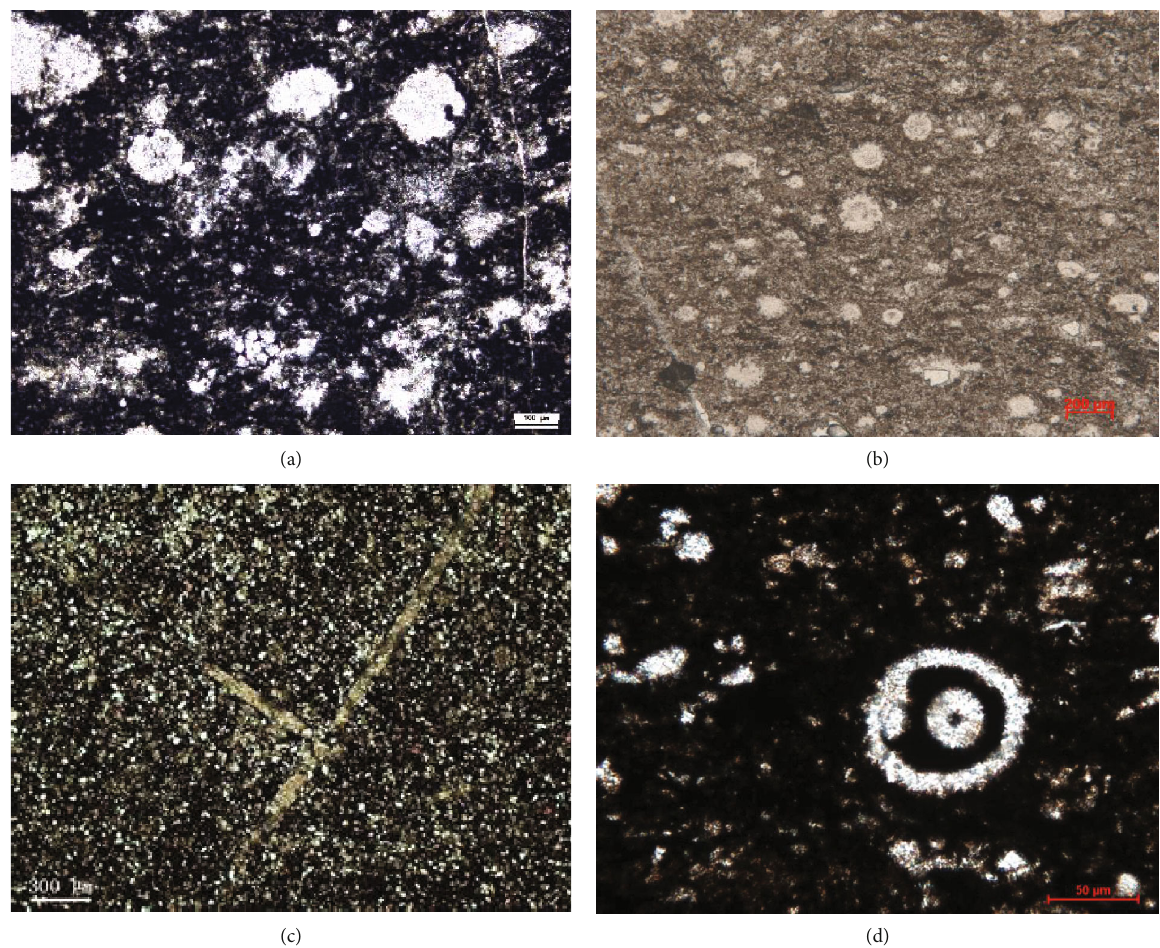
Figure 6: Intrabasinal biosiliceous debris in Wufeng and Longmaxi Formations, Fuling Shale Gas Field, Sichuan Basin. (a) Suspected pellet structure contains fossils and has an ellipsoid shape due to compaction, well JY 2, O siliceous minerals fi lling the cysts of algae at the early stage of diagenesis, well JY 2, O l , 2545.2 sponge spicule, well JY 2, S 1